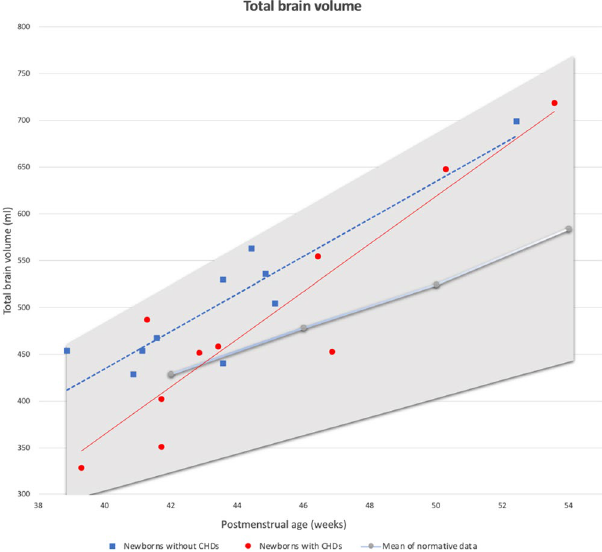
Figure 3. Total brain volume of the infants with congenital heart defects (CHDs) (red dots) and those without CHDs (blue squares). The grey line shows the mean of the reference data and the grey area shows the 95% confidence interval of normative data describing brain volume growth in infants. Milliliters